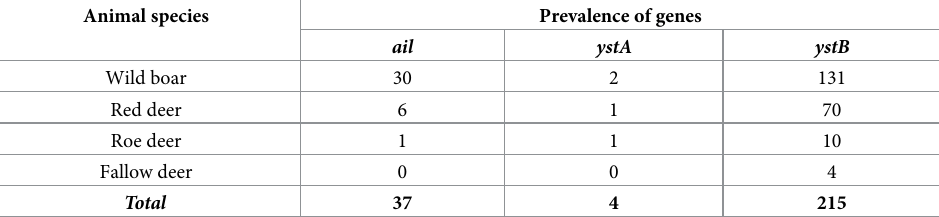
Table 3. The prevalence of ail , ystA and ystB genes in Yersinia enterocolitica isolates from game animals. Animal